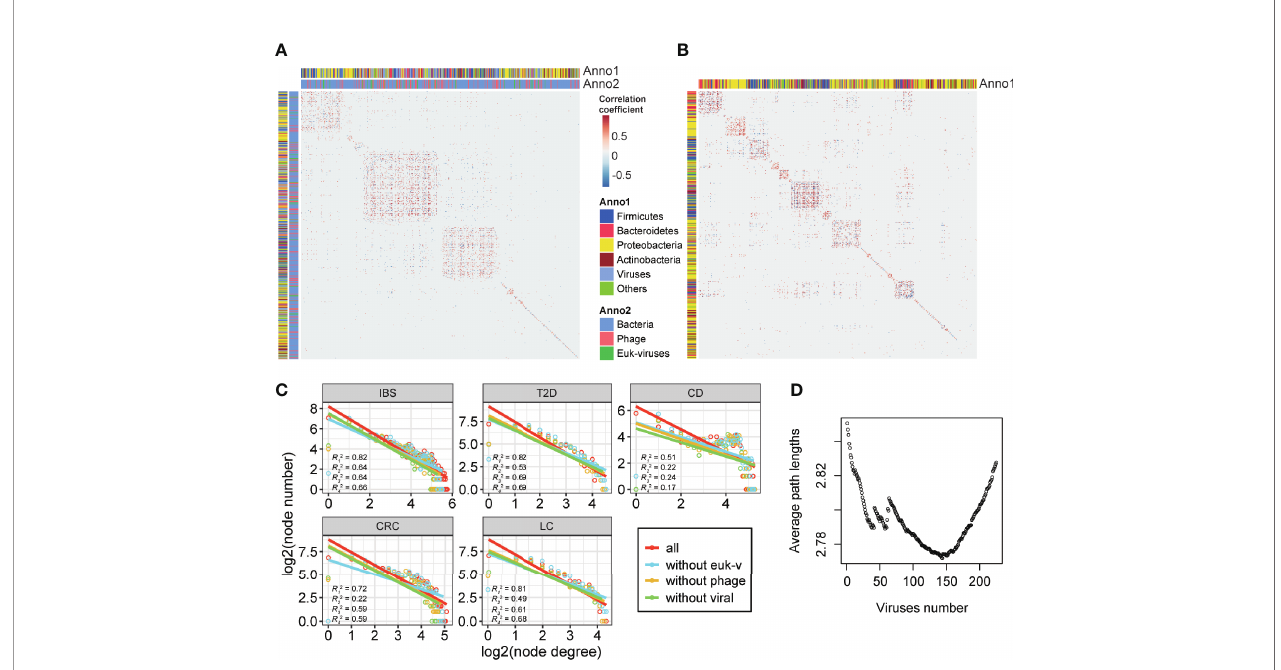
FIGURE 5 | Structural indices of disease-speci fi c networks. (A) Heatmap showing the modularity of the IBS-speci fi c co-abundance network. (B) Heatmap showing the modularity of the IBS-speci fi c co-abundance network after removing viral nodes. (C) Log2-transformed node degree distribution. Node degree is the number of direct links of a node. Degree distribution of a scale-free network follows a power-law distribution, and after log – log transformation, the distribution should fi t a linear relationship. The r-square of each line is de fi ned as the scale-free index. In each subgraph, R1 represents the line of all the nodes, R2 represents the line of nodes excluding eukaryotic viruses, R3 represents the line of nodes excluding phages, and R4 represents the line of nodes excluding all viruses. (D) Average path lengths of the pan-disease-speci fi c network in family level. Viruses were added to the bacteria network in the decreasing order of betweenness